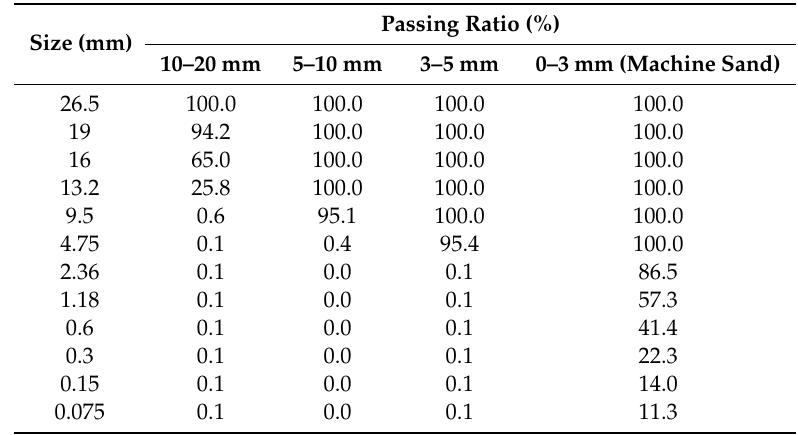
Table 4. Gradations of mineral aggregate.